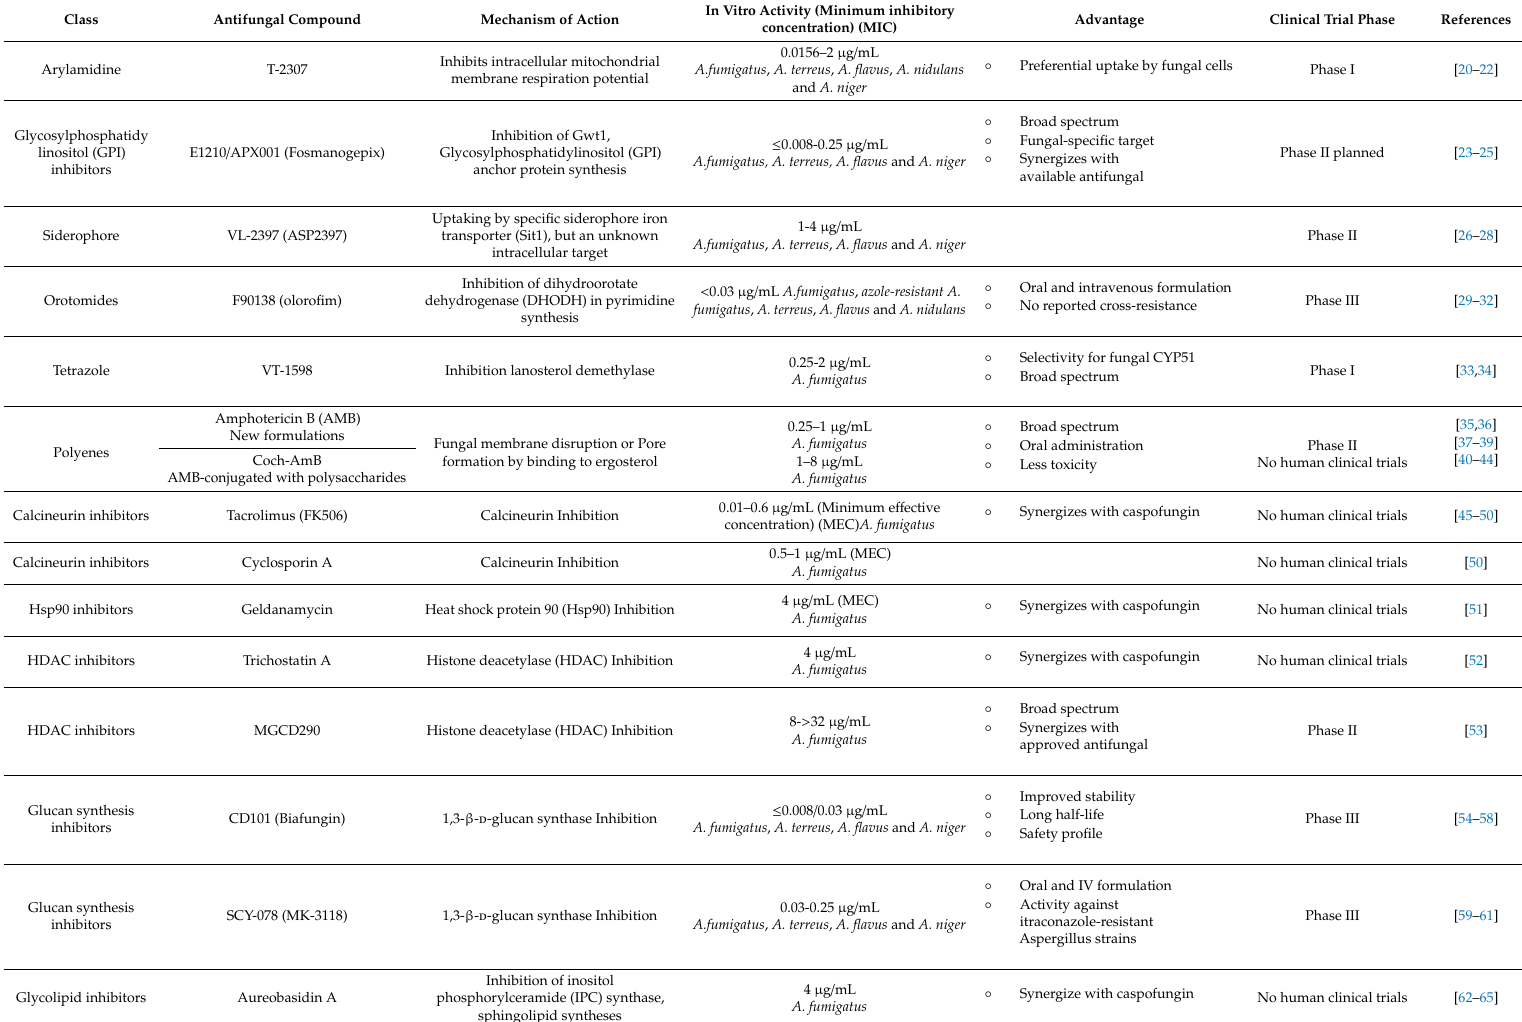
Table 1. Summary of antifungal compounds mentioned in the